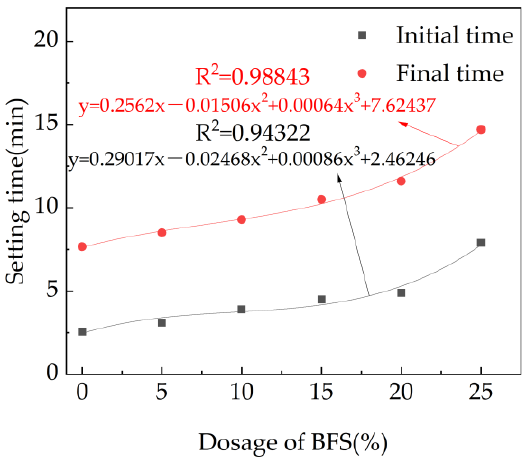
Figure 6. The setting time of fresh cement paste with BFS.